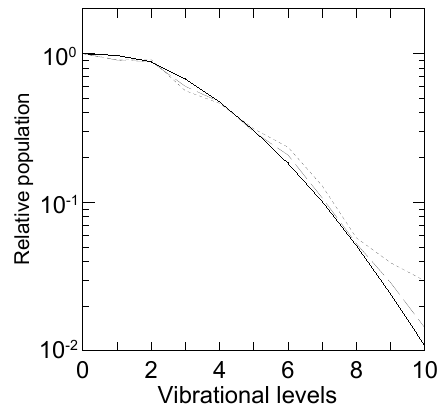
Fig. 1. Calculated relative vibrational populations Figure 1. Calculated relative vibrational populations [N 2 (B 3 Π g ,v)]/ [N 2 (B 3 Π g ,v=0)] at the [N 2 (B 3 5 g ,v )]/[N 2 (B 3 5 g ,v =0)] at altitudes 80, 95 and 150km altitudes 80, 95 and 150 km (dotted, dashed and solid lines, respectively). (dotted, dashed and solid lines, respectively).